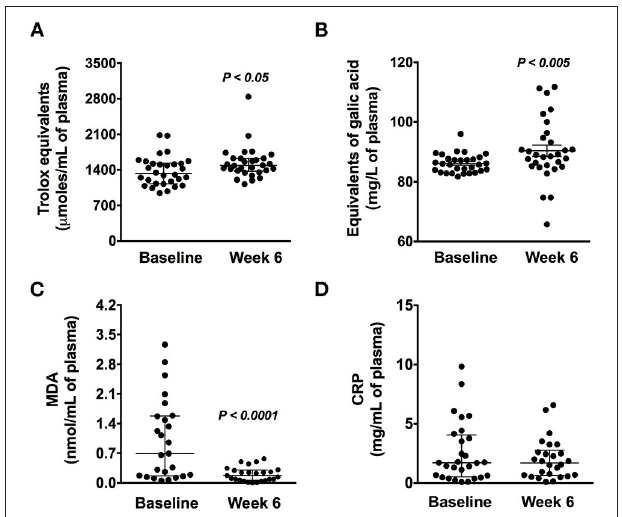
FIGURE 3 | Oxidative and inflammation markers in subjects with dyslipidemia at baseline and before Chaya intervention. (A) Antioxidant activity. (B) Plasma polyphenol concentration. (C) Plasma malondialdehyde. (D) C-reactive protein concentration. Data are expressed as the median (95% confidence interval) ( n = 30). Statistical analysis was performed using Wilcoxon